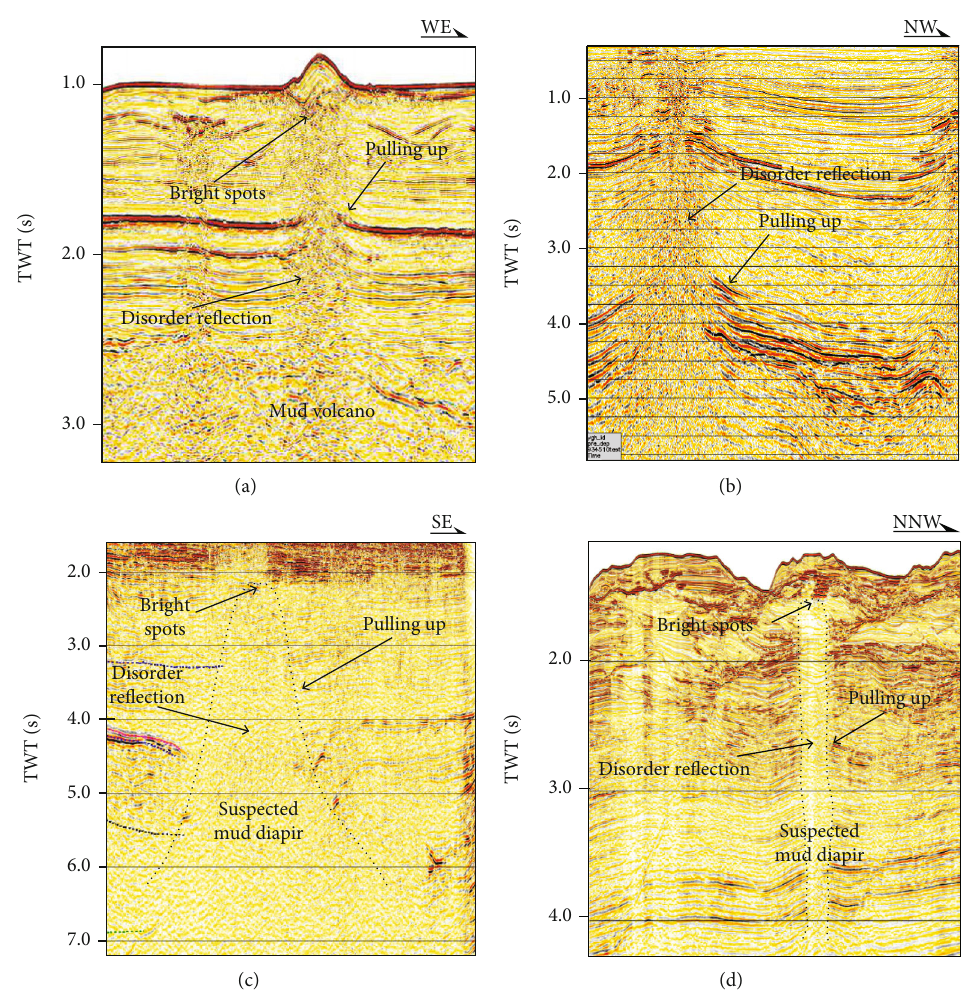
Figure 2: Four seismic pro fi les of mud diapirs in the northern basins of the South China Sea: (a) seismic re fl ection characteristic of mud diapirs developed in Zhongjiannan Basin; (b) seismic re fl ection characteristic of mud diapirs developed in Yinggehai Basin; (c) seismic re fl ection characteristic of suspected mud diapir in Qiongdongnan Basin; (d) seismic re fl ection characteristics of mud diapirs developed in Shenhu area, Pearl River Mouth